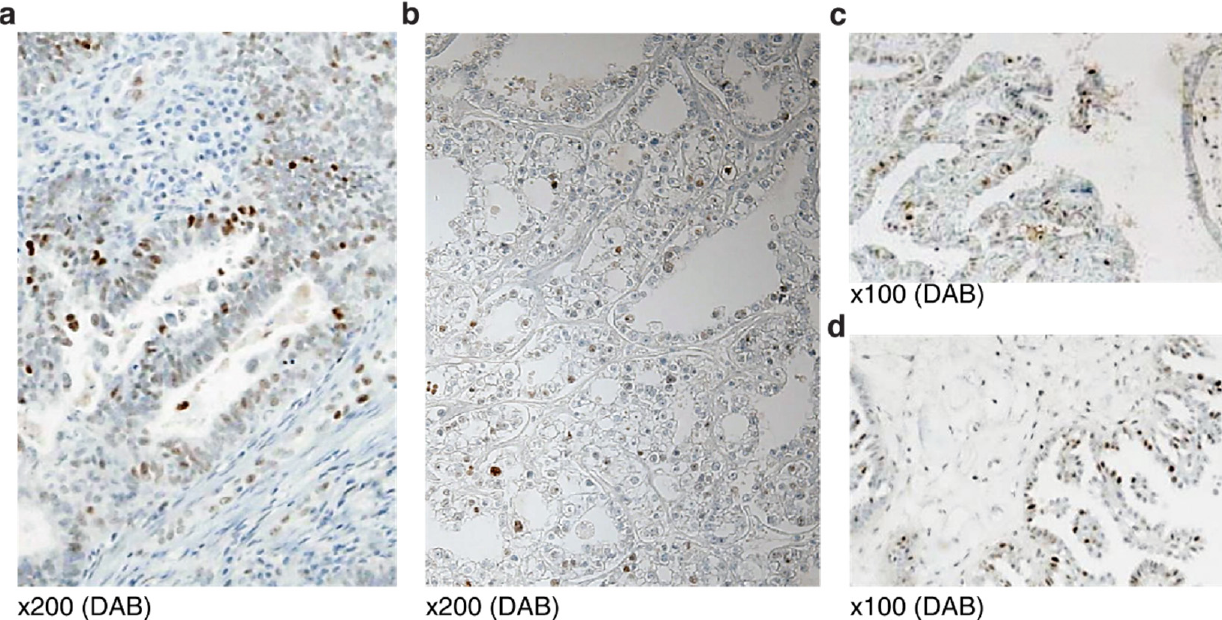
Figure 1. Wild-type p53 protein staining of non-HGSCa ovarian epithelial tumors: ( a ) Endometrioid adenocarcinoma; ( b ) clear cell adenocarcinoma; ( c ) low-grade serous carcinoma; ( d ) micropapillary serous carcinoma.